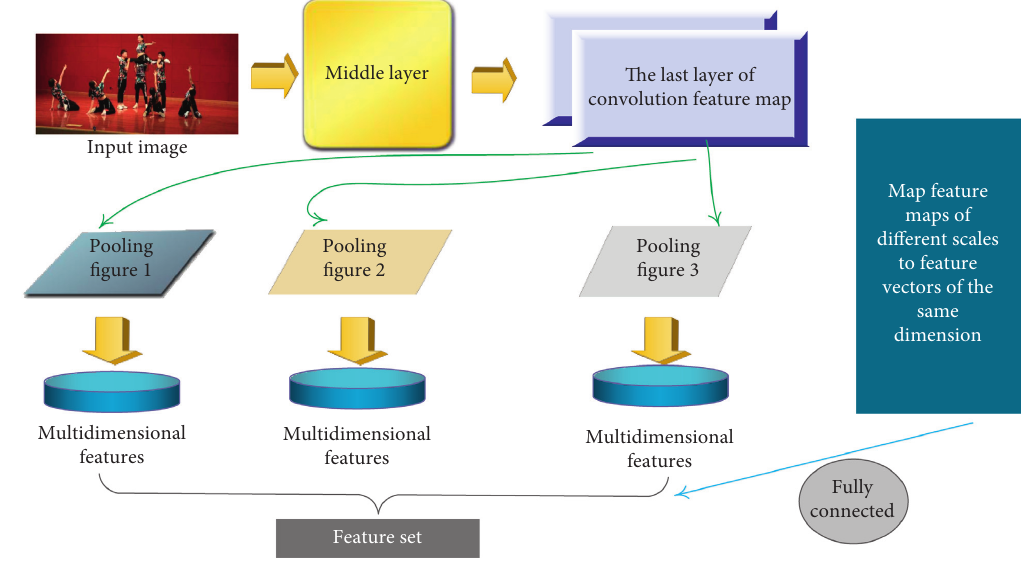
Figure 3: Schematic of spatial pyramid